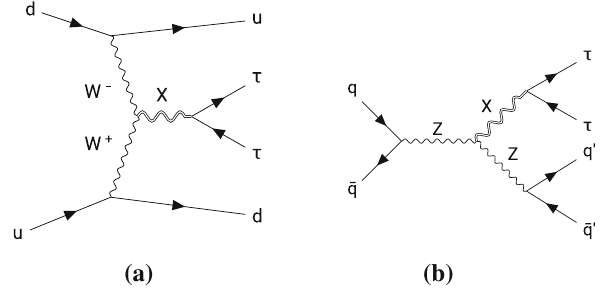
Fig. 1 Topologies of Feynman diagrams for X production through its coupling to gauge bosons. Similar diagrams, with different combina- tions of W ± ’s, Z ’s, photons and quark flavours, also exist